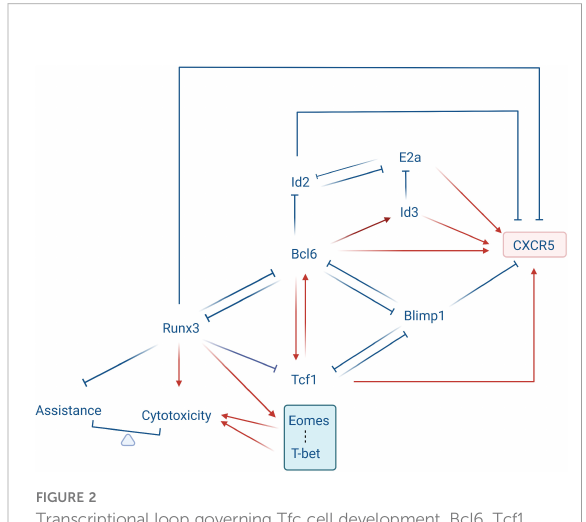
FIGURE 2 Transcriptional loop governing Tfc cell development. Bcl6, Tcf1, Eomes, and the E2a inhibitors Id2 and Id3 form a transcriptional loop that determines Tfc cell development. Tcf1 is highly expressed in Tfc cells and acts as an upstream regulator of the Bcl6-Blimp1 crosstalk, promoting Bcl6 expression while suppressing Blimp1 expression. Tcf1, Bcl6 and Blimp1 are mutually antagonistic or promoting. Bcl6 is highly expressed in Tfc cells and promotes CXCR5 protein expression while decreasing Runx3 and Id2 expression. Blimp1 is downregulated in Tfc cells, and it suppresses Cxcr5 gene transcription by binding to its 5 ’ upstream and intronic regions. E2a activation enhances Cxcr5 transcription and protein production through binding to its intron region. Id2, which antagonizes E2a transcriptional activity, suppresses Cxcr5 expression. Id3, however, a transcriptional antagonist of E2a, promotes the Cxcr5 expression. Runx3 is down-regulated in Tfc cells, it represses the Bcl6 expression and the Tfh program, and activates the cytotoxic program directly. In addition, Runx3 promotes the expression of T-box family transcription factors (T-bet and Eomes), which promotes the cytotoxicity of Tfc cells, while limiting the assistant